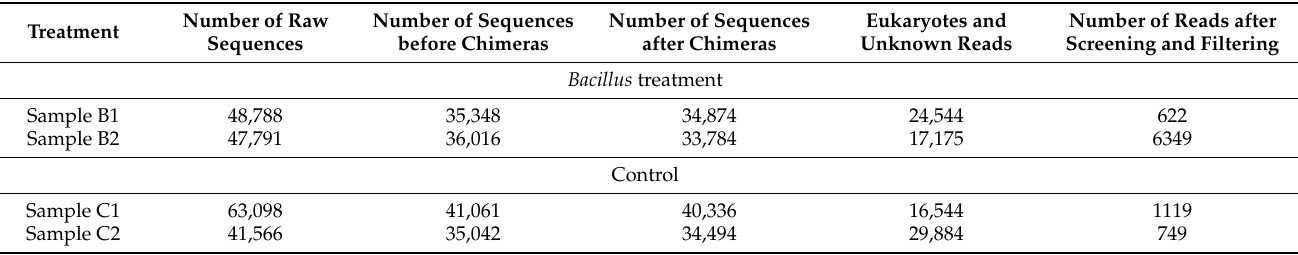
Table 3. Summary of sequencing data.